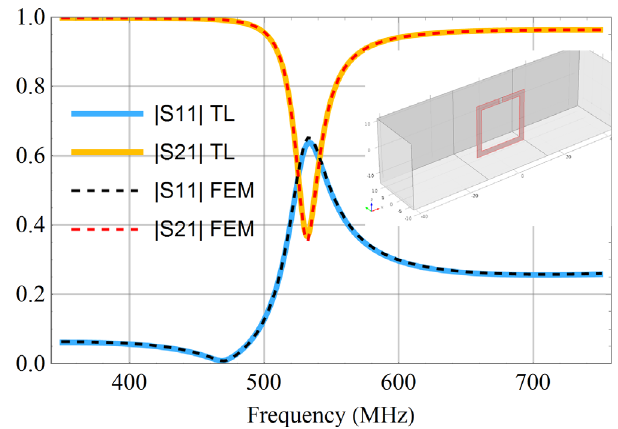
Fig. 2. Comparison of S-parameters calculated by full-wave simulations with the equivalent circuit of Figure 1 ( C 1 =0.2pF, L 1 =31.5nH, M =18.5nH, L p =45nH, C p =2pF and R p =3 V ). Insert:GeometryofthecalculatedSRR.Cellsize:25 (cid:3) 20 (cid:3) 25mm. SRR length: 20mm, SRR strip width: 2mm, SRR gap: 1.5mm. Periodic boundary conditions are assumed in both lateral